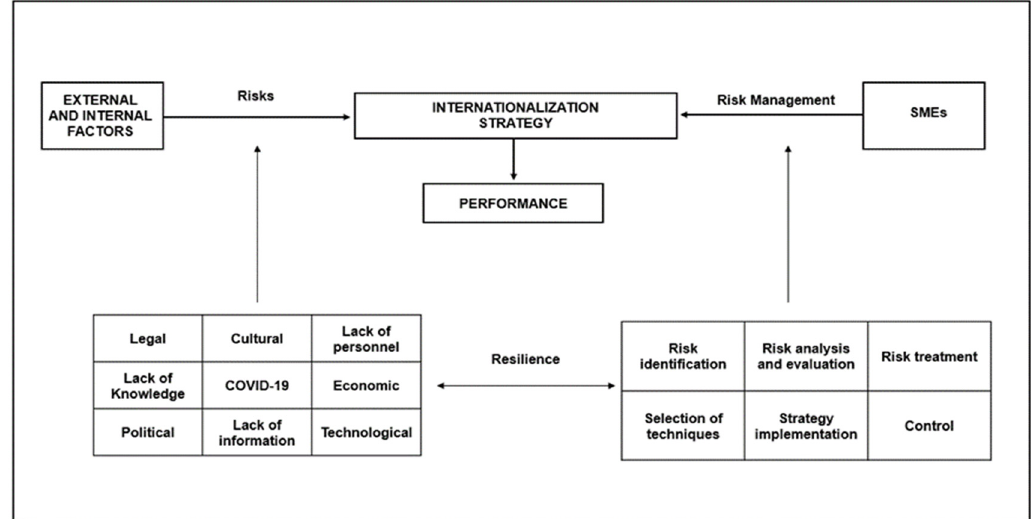
Figure 1. Theoretical framework: An integrative proposal.